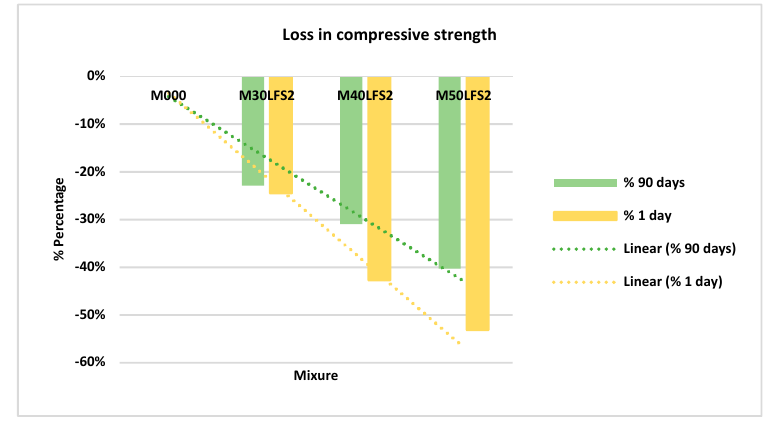
Figure 8. Percentage of loss in compressive strength LFS2.